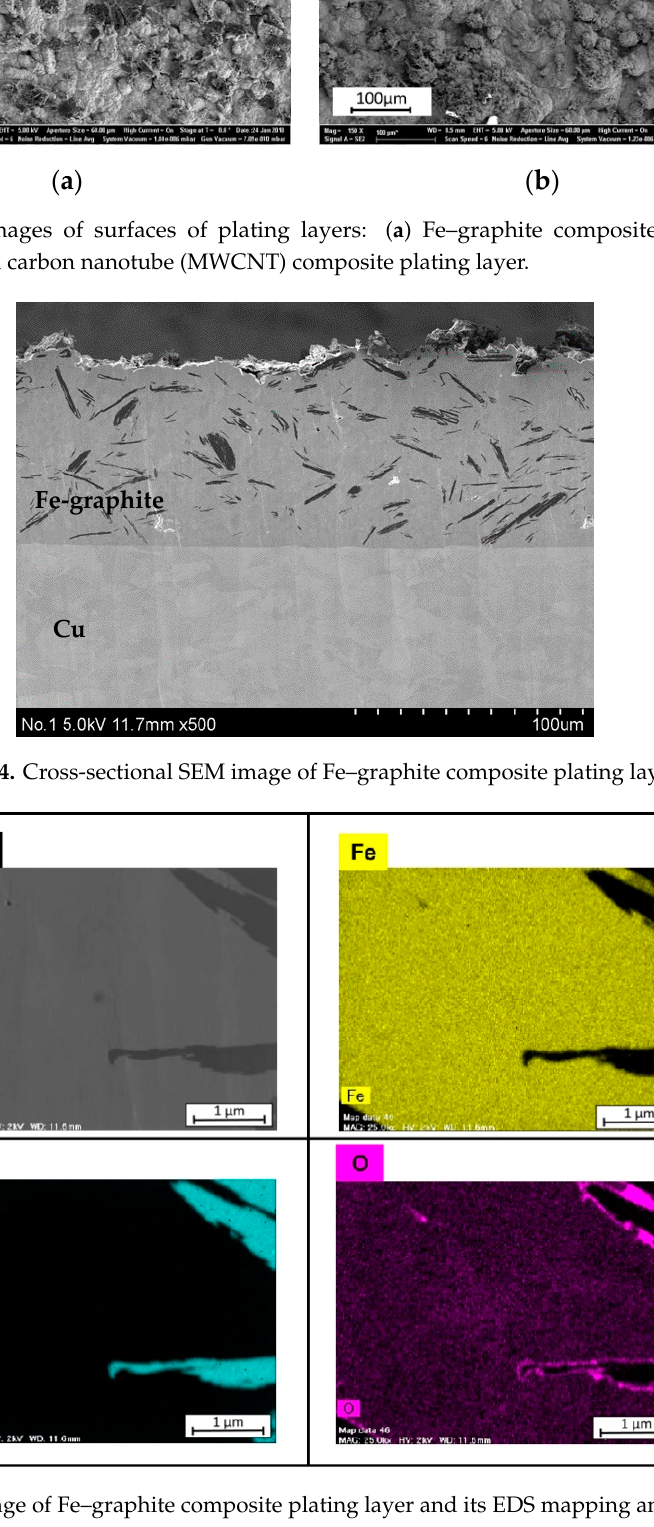
Figure 5. SEM image of Fe–graphite composite plating layer and its EDS mapping analysis results.